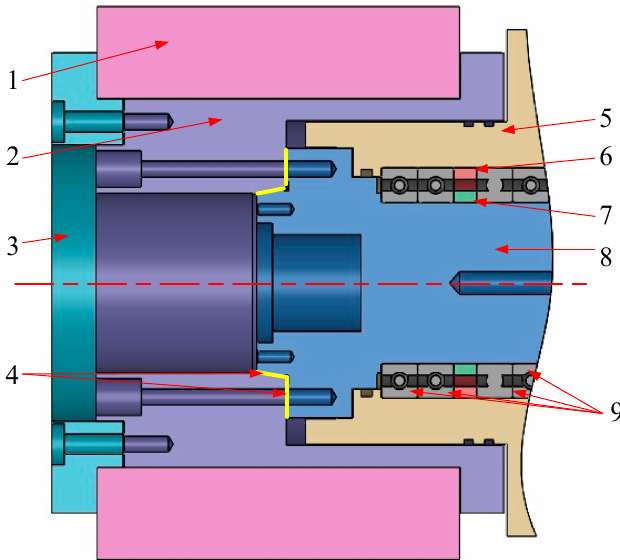
Figure 1. Schematic of the worm grinding-wheel assembly.